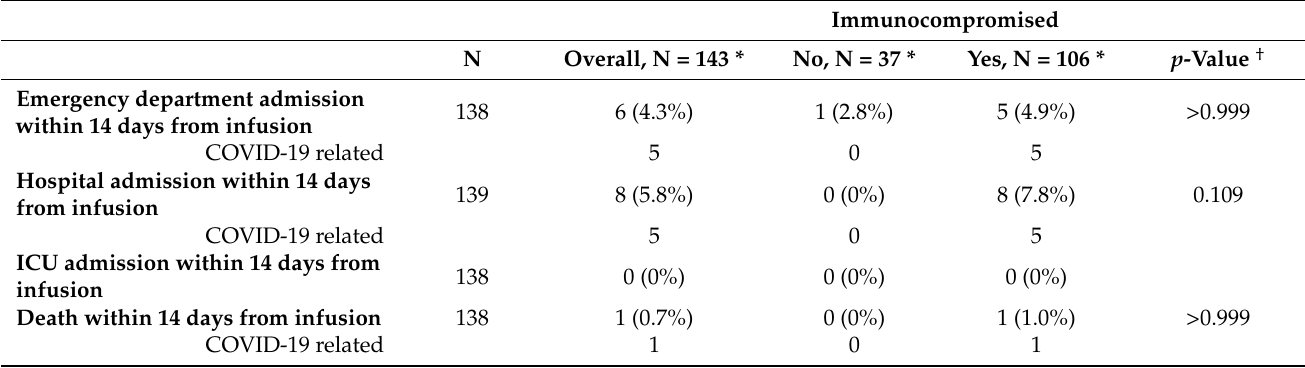
Table 4. Treatment induced adverse events by therapy administered and stratified according to immunocompromised status. Immunocompromised N Overall, N = 143 * No, N = 37 * Yes, N = 106 * p -Value